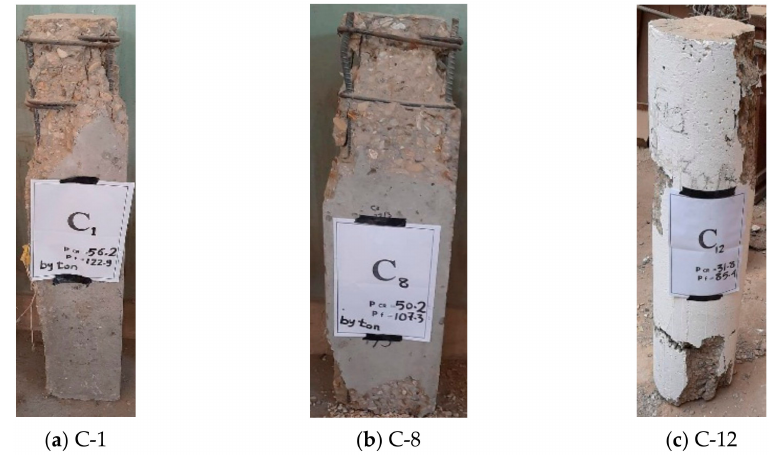
Figure 4. Crack patterns of the control RC columns without strengthening.